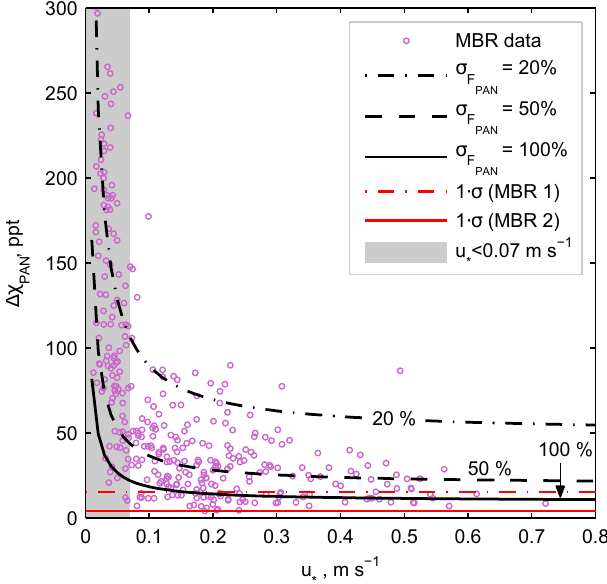
Figure 10. 1χ PAN values during the MBR operation against u ∗ (vi- olet circles) are shown together with fitted lines of relative random flux errors of 20, 50 and 100% (black lines) at the Mainz-Finthen grassland site. The red lines mark the precision for the 1χ PAN mea- surement determined from side-by-side measurements. Values be- low this precision were excluded from the plot. The grey area with u ∗ < 0.07ms − 1 indicates fluxes with high relative random